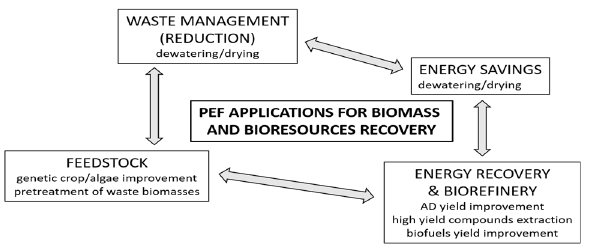
Figure 3. Possible PEF applications for biomass and bioresources recovery .